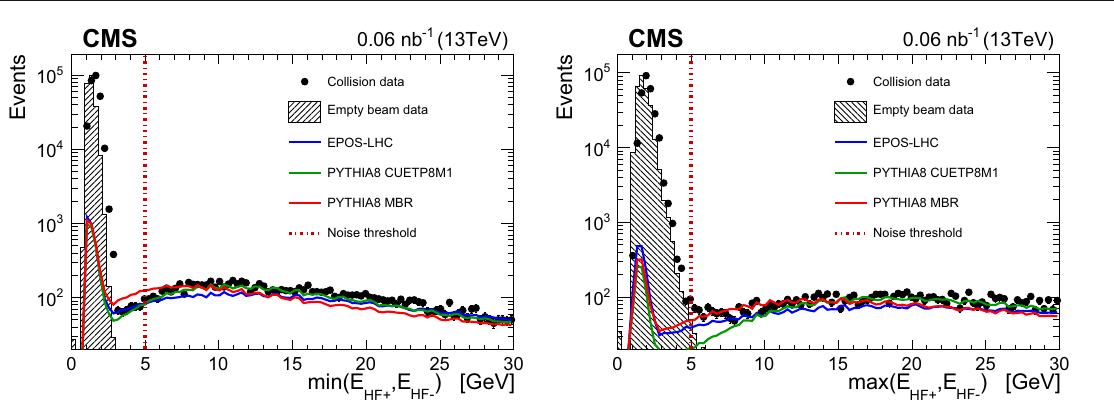
energies, max( E HF − , E HF + ). The lines represent the simulations, while the markers represent the data. The measured detector noise distribu- tions are shown as shaded